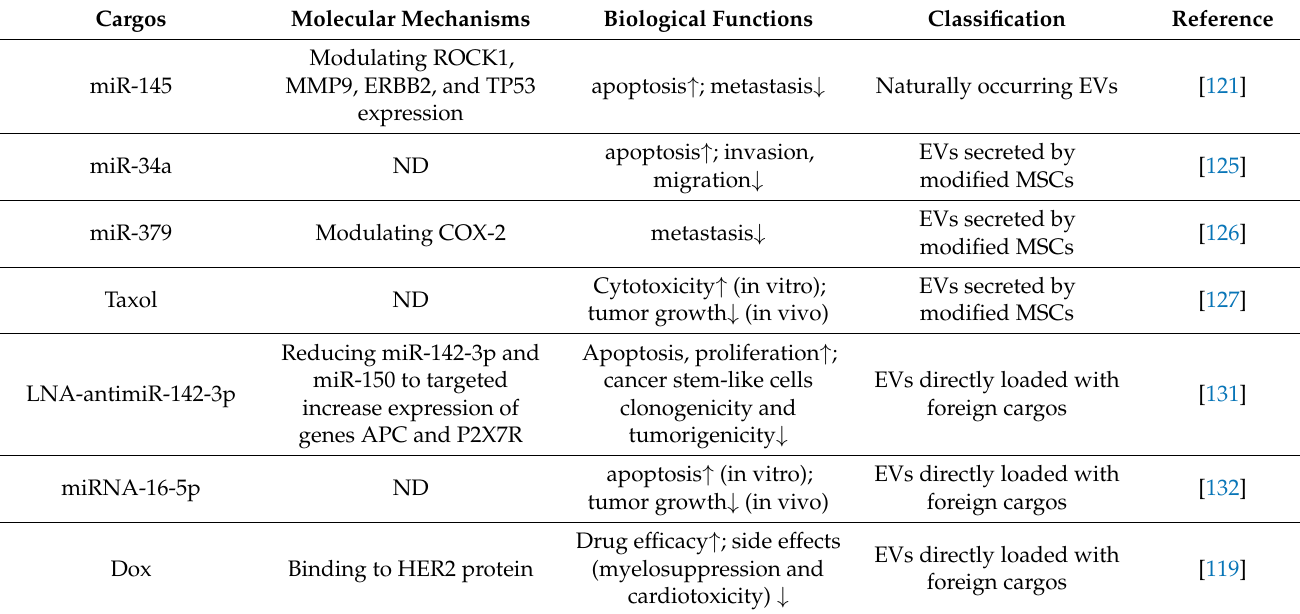
Table 2. The clinical role of MSC-EVs in breast